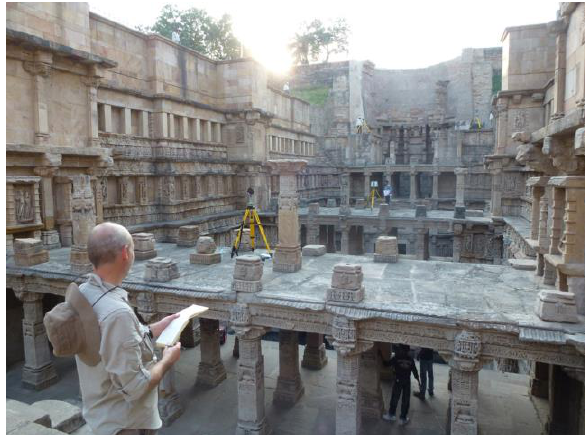
Figure 6. Rani ki Vav stepwell, Gujarat, India © CDDV 2011.